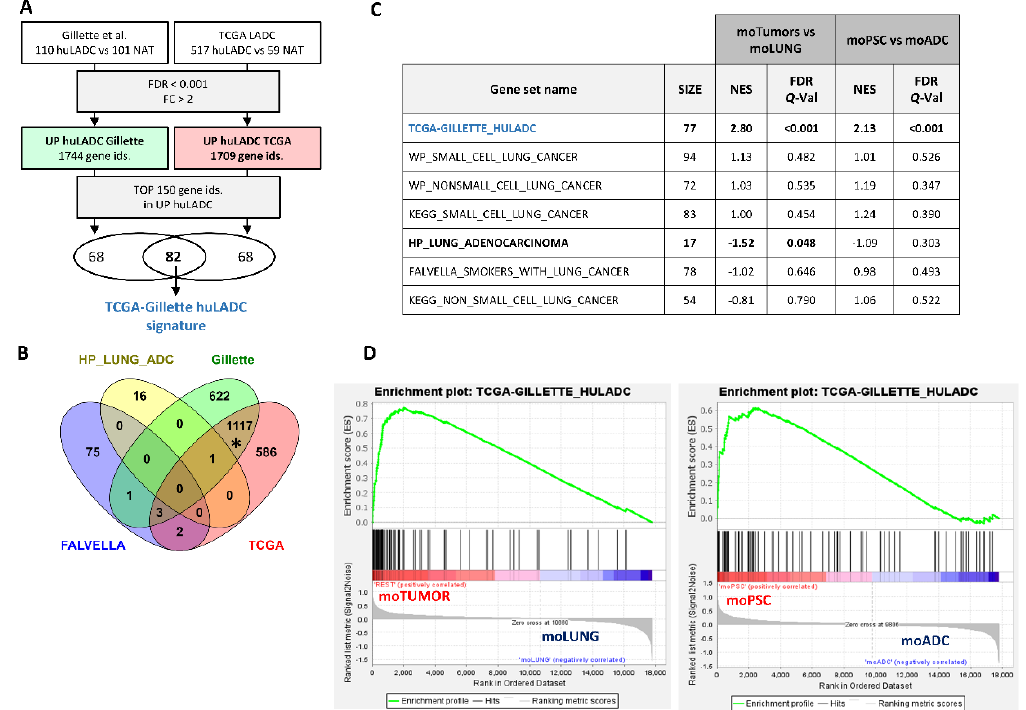
Figure 6. Gene expression studies of a human lung ADC signature on mouse ADC and PSC tumors . ( A ) Flow diagram followed to obtain a human LADC gene signature based on the Gillette et al. and the TCGA lung adenocarcinoma RNAseq data. Numbers indicate Affymetrix probe set identifiers. ( B ) Venn diagram [39] showing the overlap among TCGA, Gillette and MSigDB adenocarcinoma gene signatures (FALVELLA and HP_LUNG_ADENOCARCINOMA). Hypergeometric test was used to assess the statistical significance of the overlap: * p < 0.0001, representation factor 7.5; the rest p > 0.05. NAT: normal adjacent tissue; huADC: human lung adenocarcinoma. ( C ) Gene enrichment analysis of the indicated gene sets in the mouse tumors compared to control lung (moTumors vs. moLUNG), and in PSC compared to ADC mouse tumors (moPSC vs. moADC). Significant (FDR Q -Val < 0.25) gene sets are highlighted in bold. SIZE: number of genes in gene set. NES: Normalized Enrichment Score. The normalized enrichment score (NES) is used to compare analysis results across gene sets. ( D ) Enrichment plots for the TCGA-GILLETTE_HULADC gene set. The enrichment score (ES) reflects the degree to which the gene set is overrepresented at the top (positive ES values) or bottom (negative ES values) of the ranked list of genes in the expression dataset.